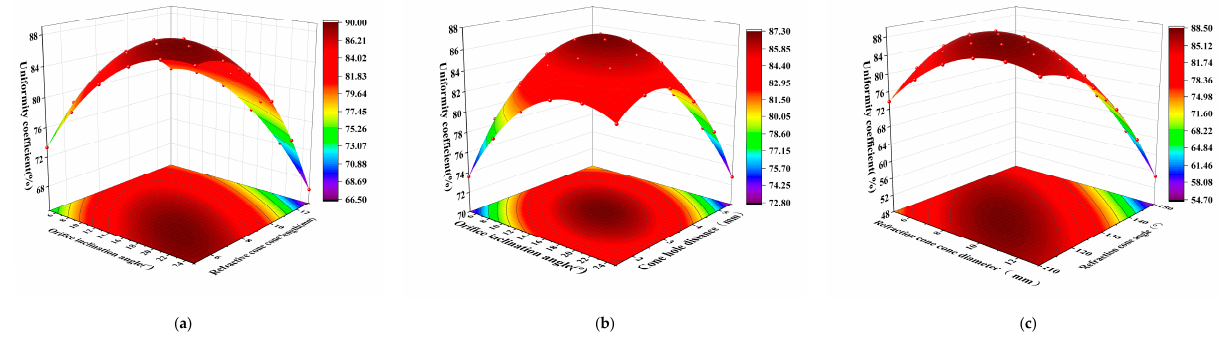
Figure 9. Two-factor interaction effect diagram of uniformity coefficients. ( a ) Interaction effect between α and l . ( b ) Interaction effect between α and h , ( c ) Interaction effect between l and θ .